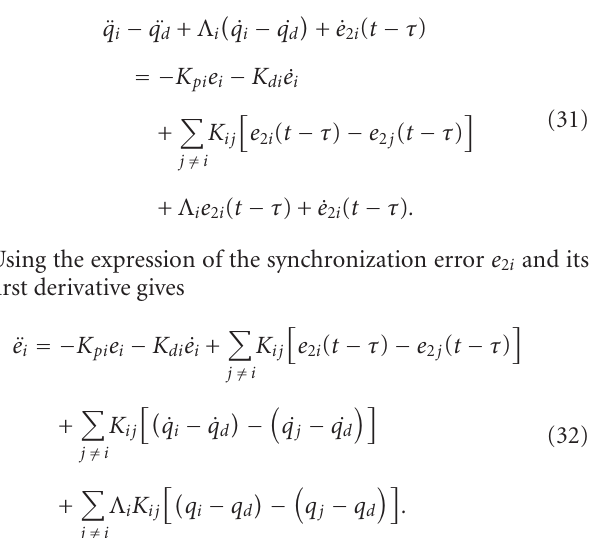
Figure 10: Robots synchronization without time delay.